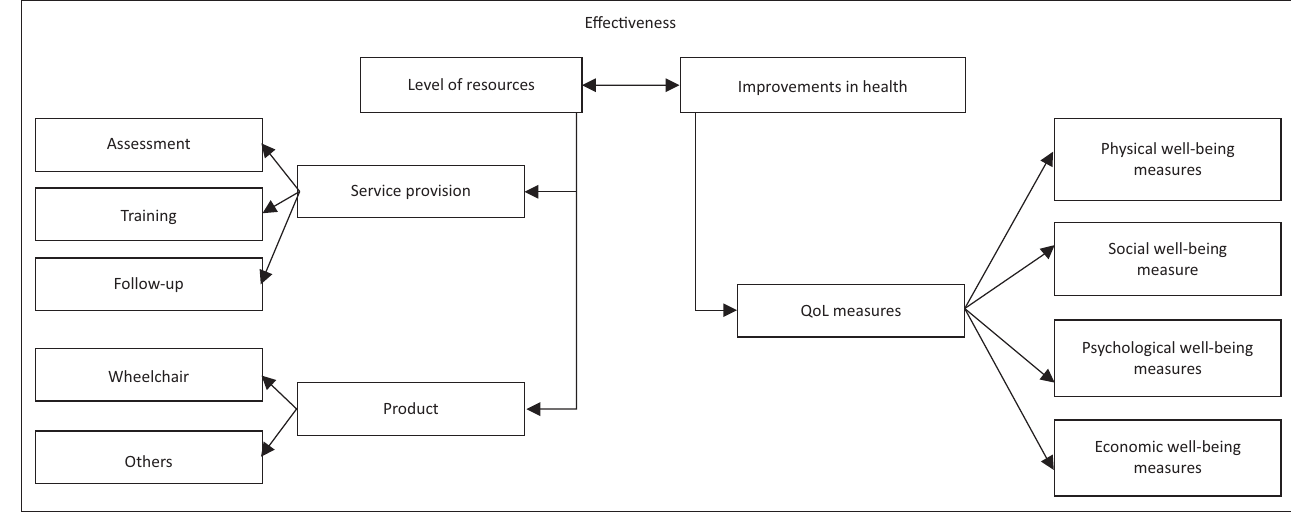
FIGURE 1: Version 1 of the conceptual